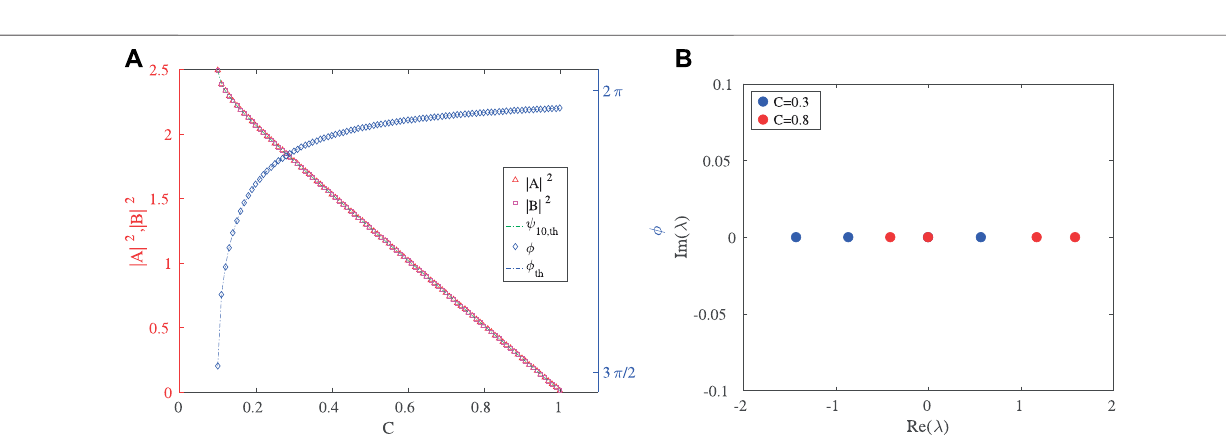
Frontiers in Physics |